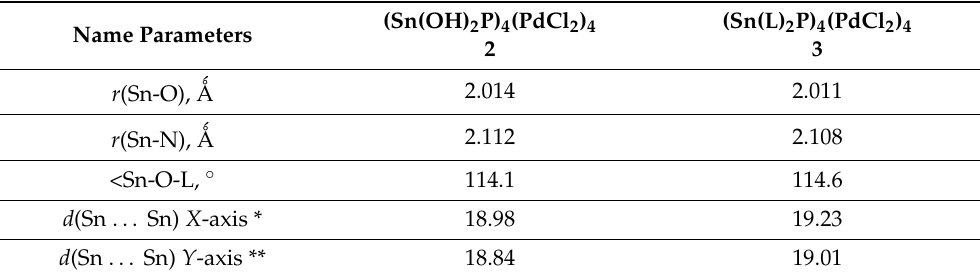
Table 7. Geometrical parameters of the studied compounds obtained by quantum chemical calcula- tions using the method